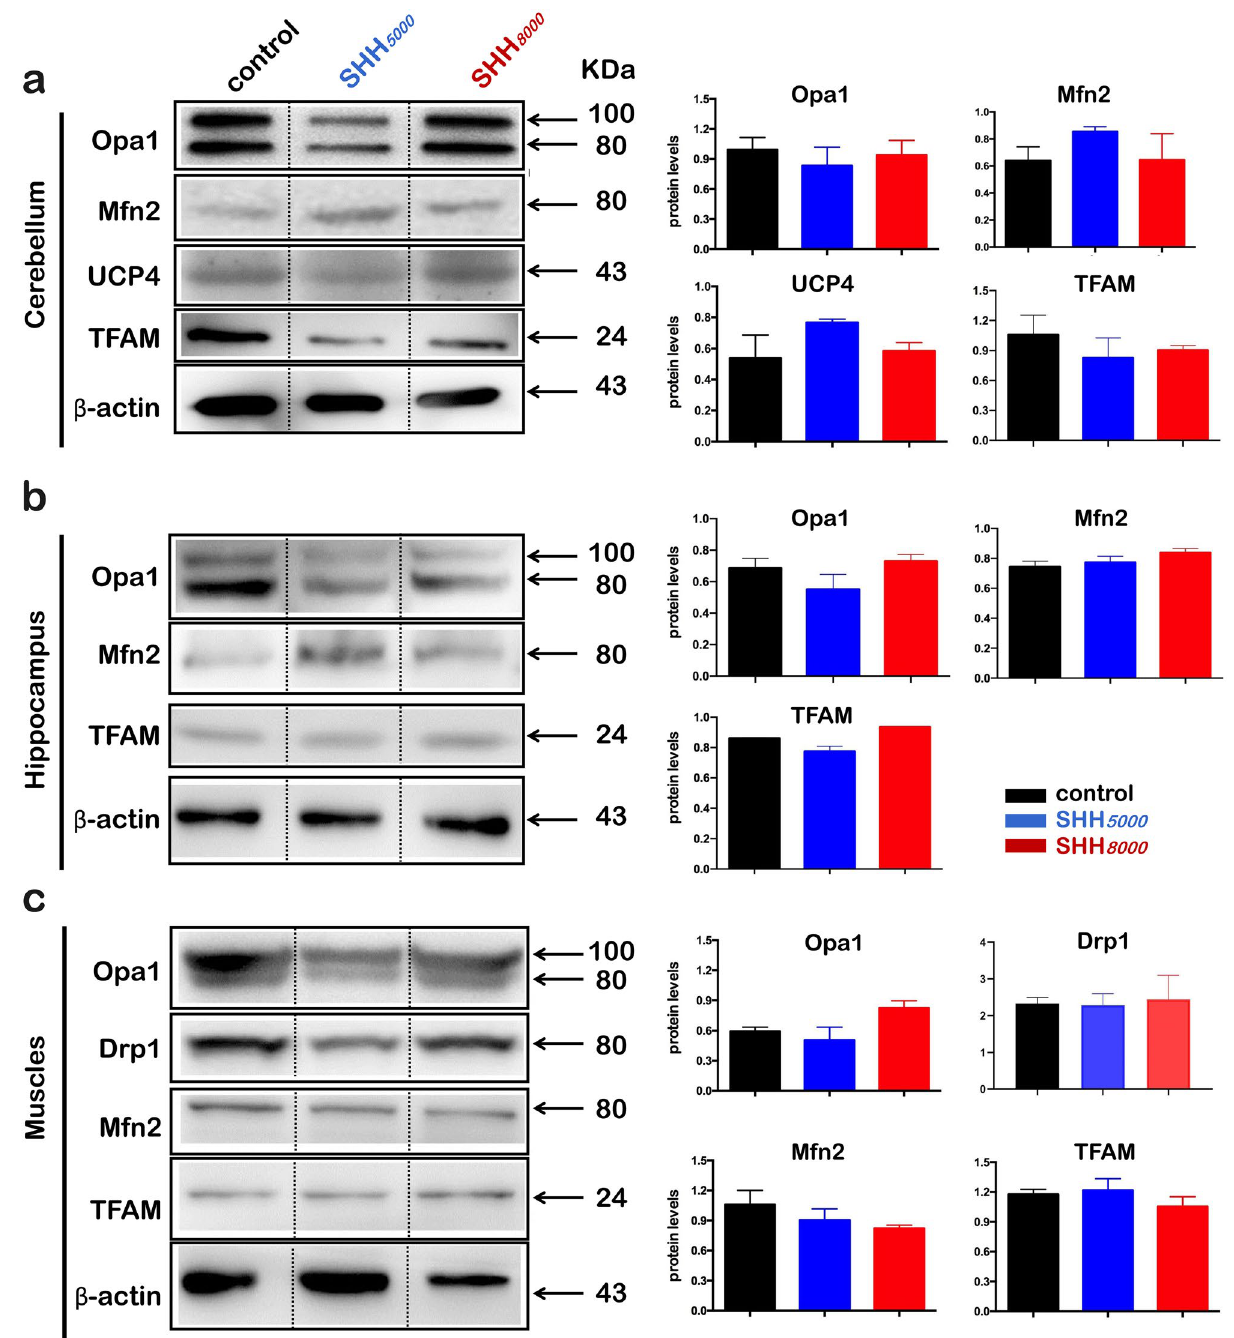
Figure 7. Protein expression levels showed a trend similar to those of the mRNA levels. ( a ) Normal mice were sacrificed after SHH 5000 or SHH 8000 treatment for 16 h. Each cerebellum was collected and immediately stored in liquid nitrogen. Western blotting was then performed to detect differences in mitochondrial- related protein expression levels (Mfn2, Opa1, TFAM, UCP4). ( b ) Western blotting was performed to detect differences in mitochondrial-related protein expression levels (Mfn2, Opa1, TFAM) in each mouse hippocampus after SHH 5000 or SHH 8000 treatment. ( c ) Western blotting was performed to detect differences in mitochondrial-related protein expression levels (Mfn2, Opa1, TFAM) in the muscles of mice after SHH 5000 or SHH 8000 treatment. Data are analyzed by Image J software, and are presented as the mean ± SD. * P < 0.05, ** P < 0.01, *** P < 0.001, compared with the control group, n = 5 per group. Full-length blots/gels are presented in Supplementary Fig. 1a–c. Mfn2, mitochondrial fusion protein 2, a mitochondrial fusion factor on the mitochondrial outer membrane; Opa1, Optic atrophy1, a mitochondrial fusion factor on the mitochondrial inner membrane; TFAM, mitochondrial transcription factor; UCP4, uncoupling protein 4, a mitochondrial stress factor; SHH 5000 ,simulated hypobaric hypoxia at an altitude of 5000 m; SHH 8000 , simulated hypobaric hypoxia at an altitude of 8000